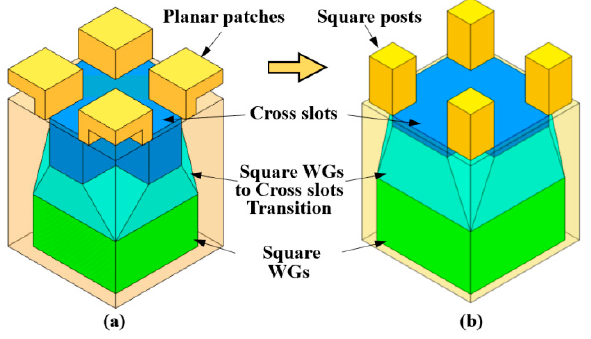
Figure 1. Dual-polarization ME-dipole unit: ( a ) planar patches; ( b ) square posts.